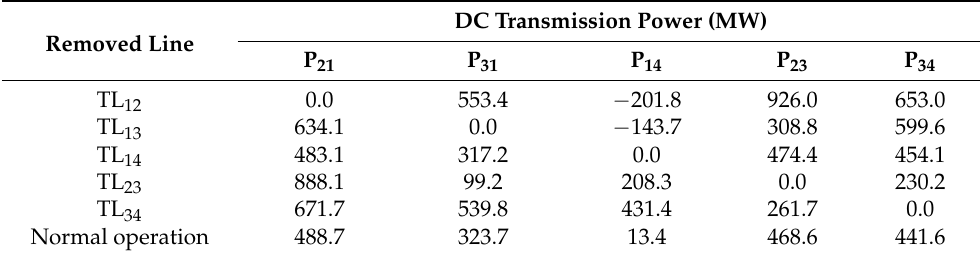
Table 4. DC transmission power flow with different removed